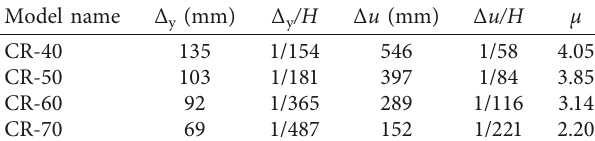
Table 5: Displacement ductility coefficients of the models.